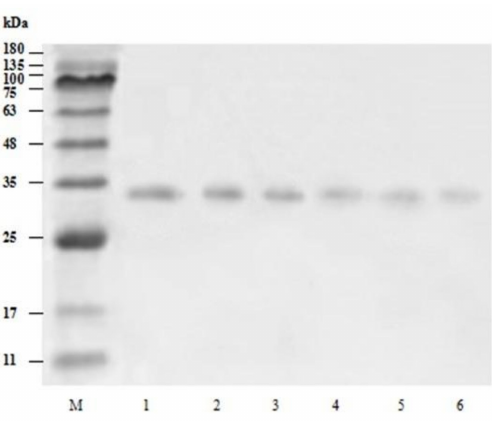
Figure 6. Changes in the molecular weight of trypsin after exposure to ACP at different voltages, M stands for Marker (molecular weight of standard). Lanes: 1, 0 kV; 2, 10 kV; 3, 20 kV; 4, 30 kV; 5, 40 kV; 6, 50 kV.